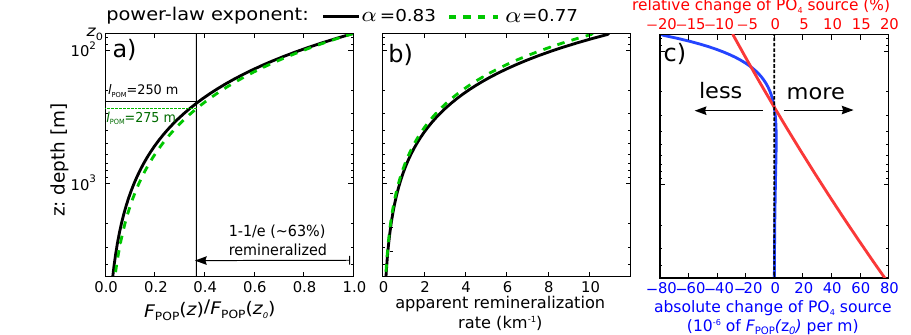
Figure 2. (a) Parametrisation of the particulate organic matter flux within the water column (expressed here in terms of POP) out of the euphotic zone ( z 0 = 75m) according to a power law F(z) = F(z 0 ) · (z/z 0 ) − α , with α = 0.83 being the base case (black line). The depth is positive downwards (note the logarithmic scaling). (b) The apparent rate of remineralisation ( k/v ), i.e. − ( d F(z)/ d z)/F(z) . The green line represents the corresponding values for a hypothetical deepening of the POM remineralisation ( α = 0.83 → 0.77, or expressed as a change in the e-folding depth l POM , 250m → 275m). Such a change leads to a decrease in the upper ocean PO 4 source, while the deep ocean (below ∼ 250m) is enriched in PO 4 , as depicted in (c)